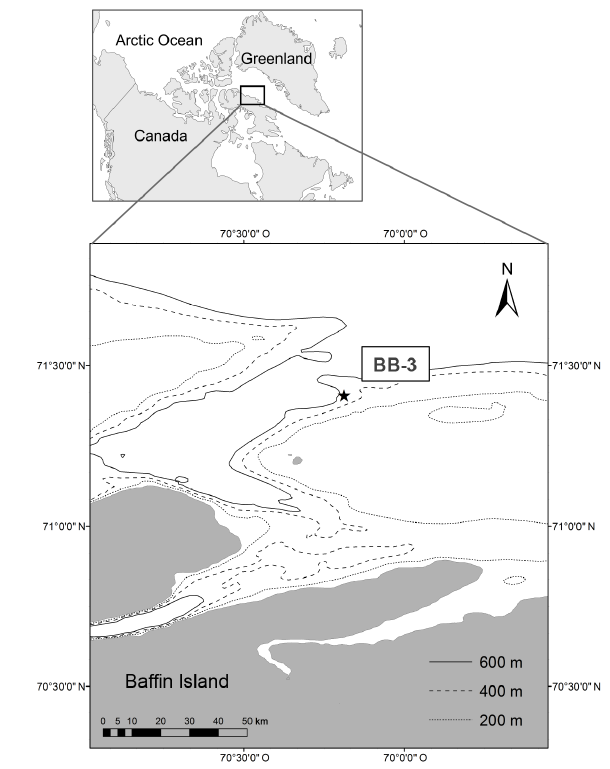
Figure 1. Map showing the location of station BB-3 (71 ◦ 24.373 (cid:48) N, 70 ◦ 11.269 (cid:48) W), where seawater was collected for the incubation ex-